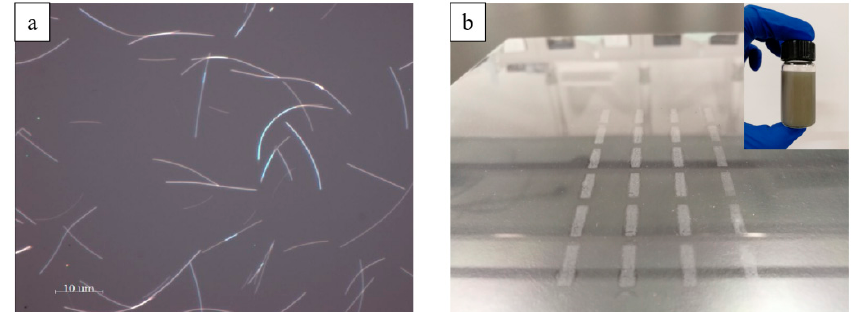
Figure 1. ( a ) Optical microscope image of prepared silver nanowires. ( b ) The photo of screen-printed AgNWs patterns; the inserted image was as-synthesized silver nanowires ink.